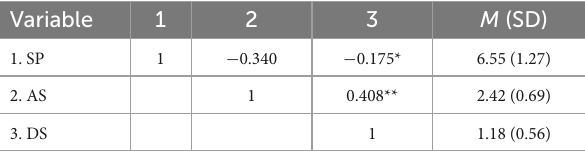
TABLE 2 Descriptive statistics and Pearson correlation coefficients of study